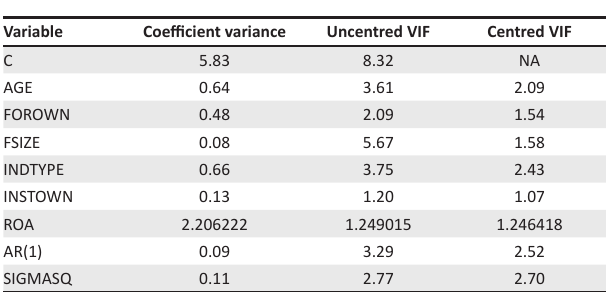
TABLE 5 : Variance inflation